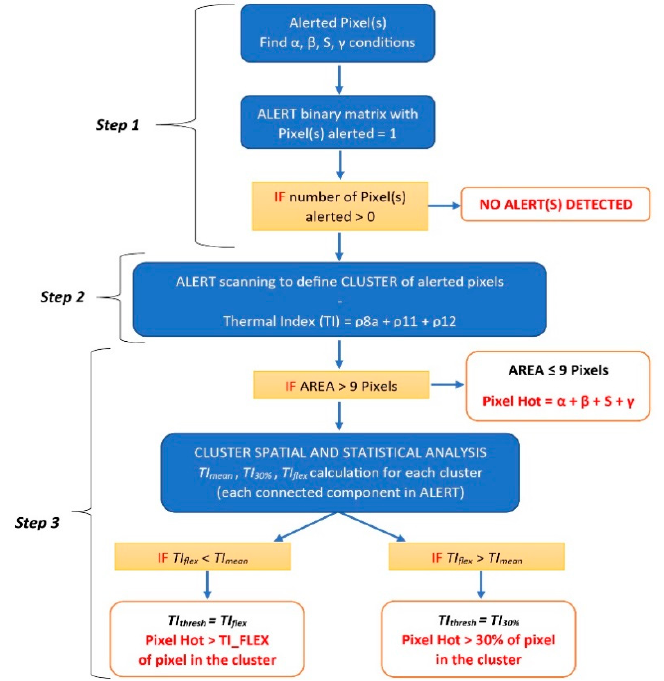
Figure 3. Flowchart of the algorithm. In blue boxes are the conceptual steps; in yellow, the logical conditions; and in red, the results. On left side, the three main steps of the algorithm are indicated.